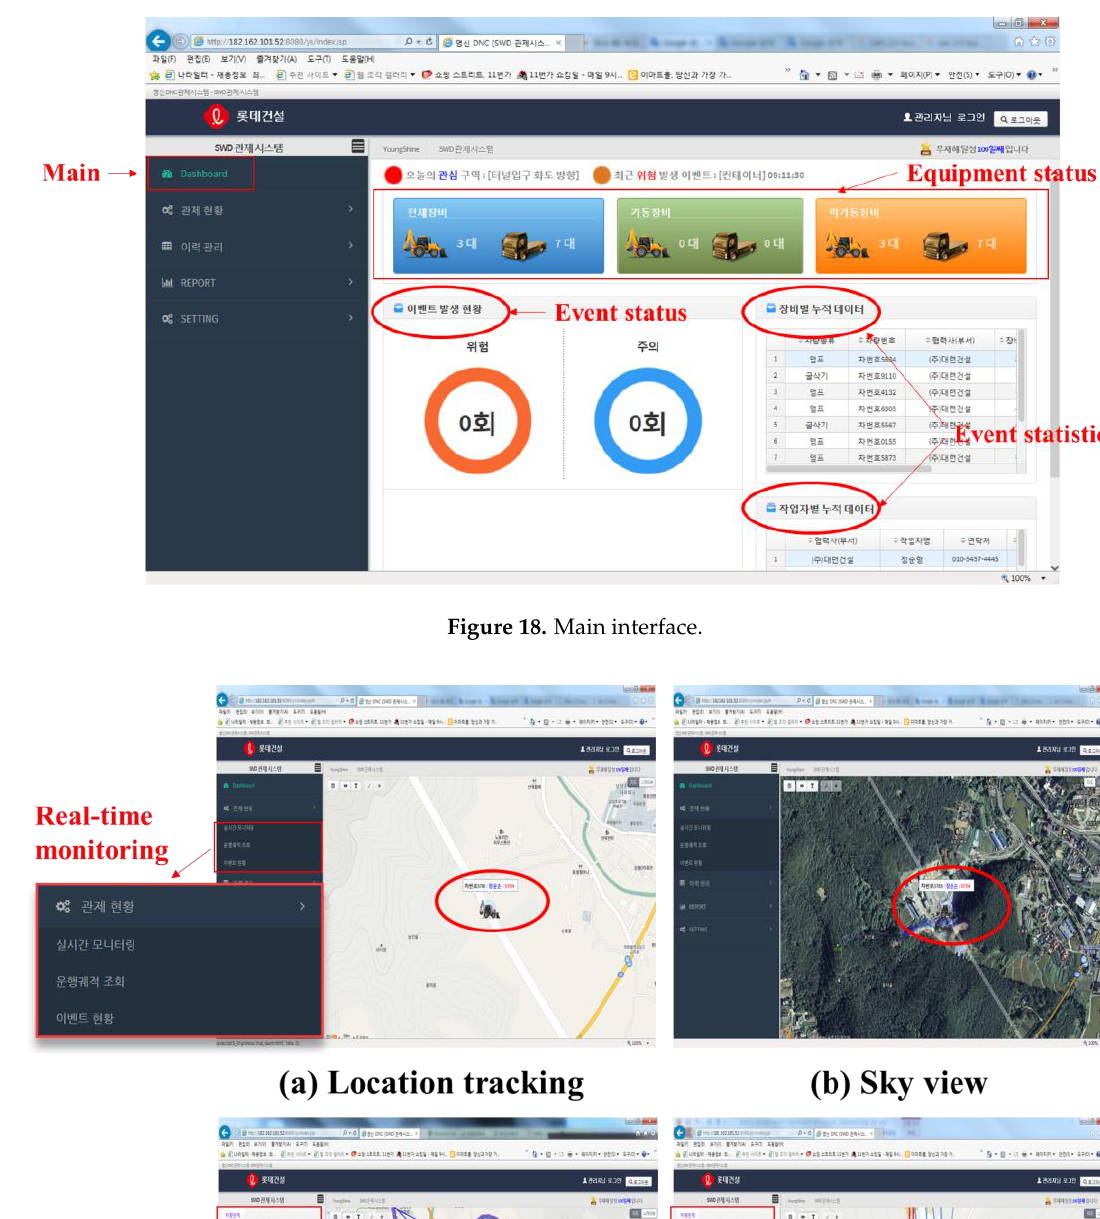
Figure 20. Resource management. The third box in the menu box is related to resource management. This menu shows the operation time as well as the event status of equipment and workers using their device’s IDs , PPU and UMCU. The histories of the equipment and workers can be downloaded as Excel files (shown in